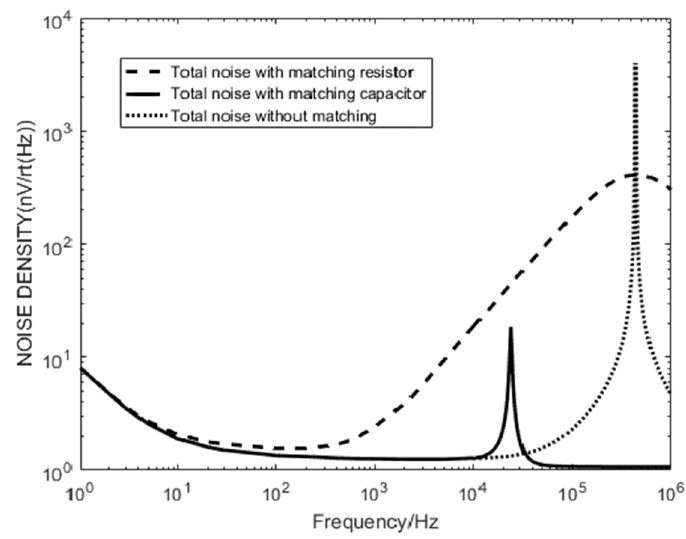
Figure 12. Comparison of sensor noise in three modes.